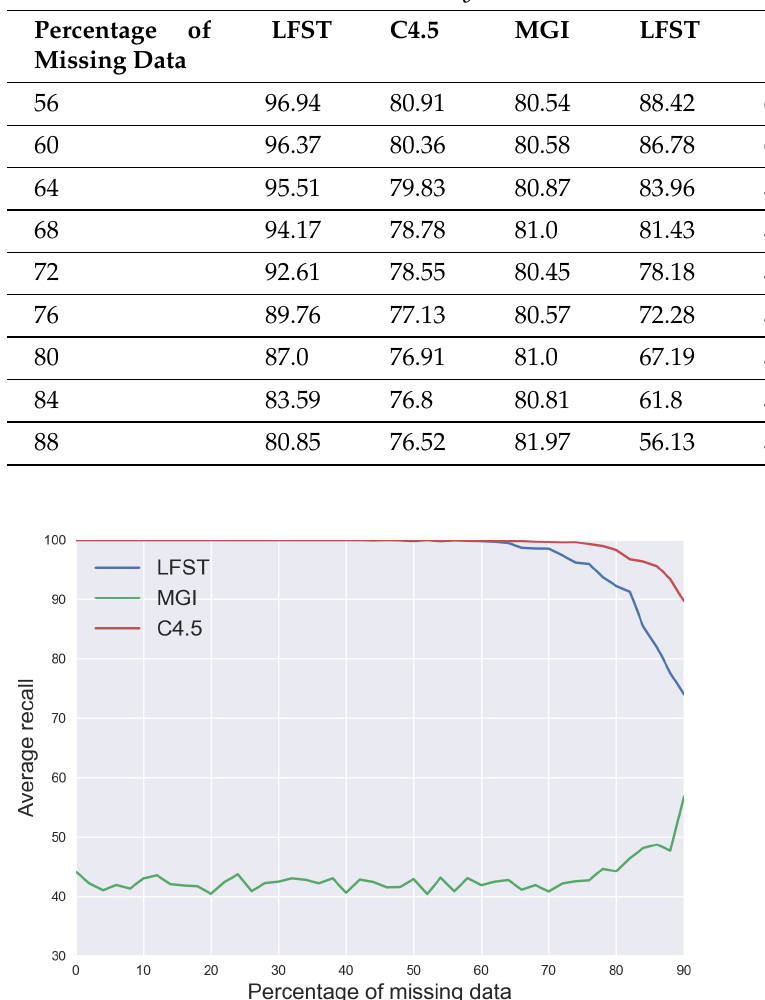
Figure 7. Comparison of the average recall in GridWorld.